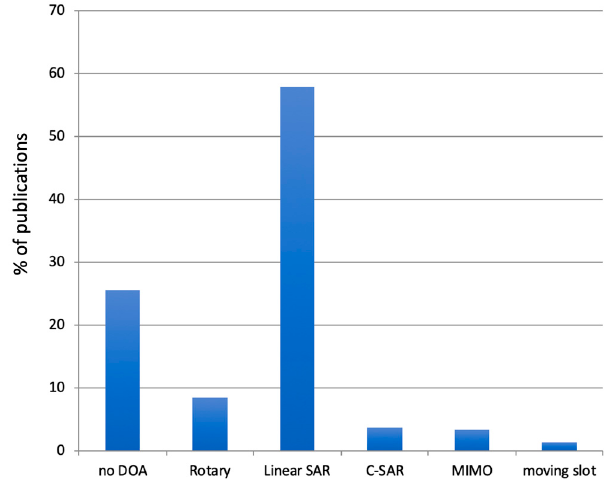
Figure 5. Papers published until December 2018 classified on the basis of the operative modality.